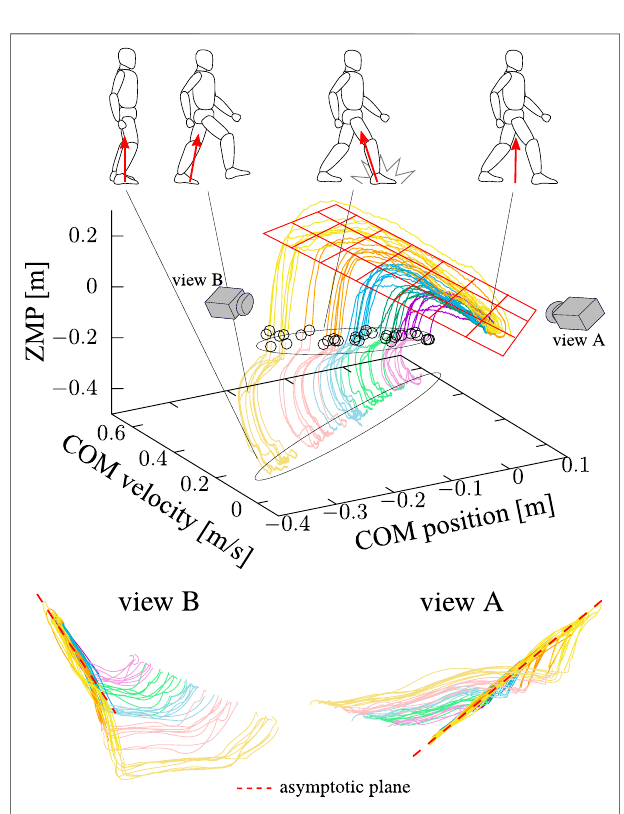
FIGURE 7 | Collected trajectories of step-and-brake motions in x - _ x - x space. The fi nal position of each trajectory is reset to be the original point. Trajectories with the same foot-landing destination are grouped by the same color. Black circles indicate the detected moments of foot-landing on each trajectory. Figures from two different viewpoints implicate the existence of an asymptotic plane (red dashed lines).